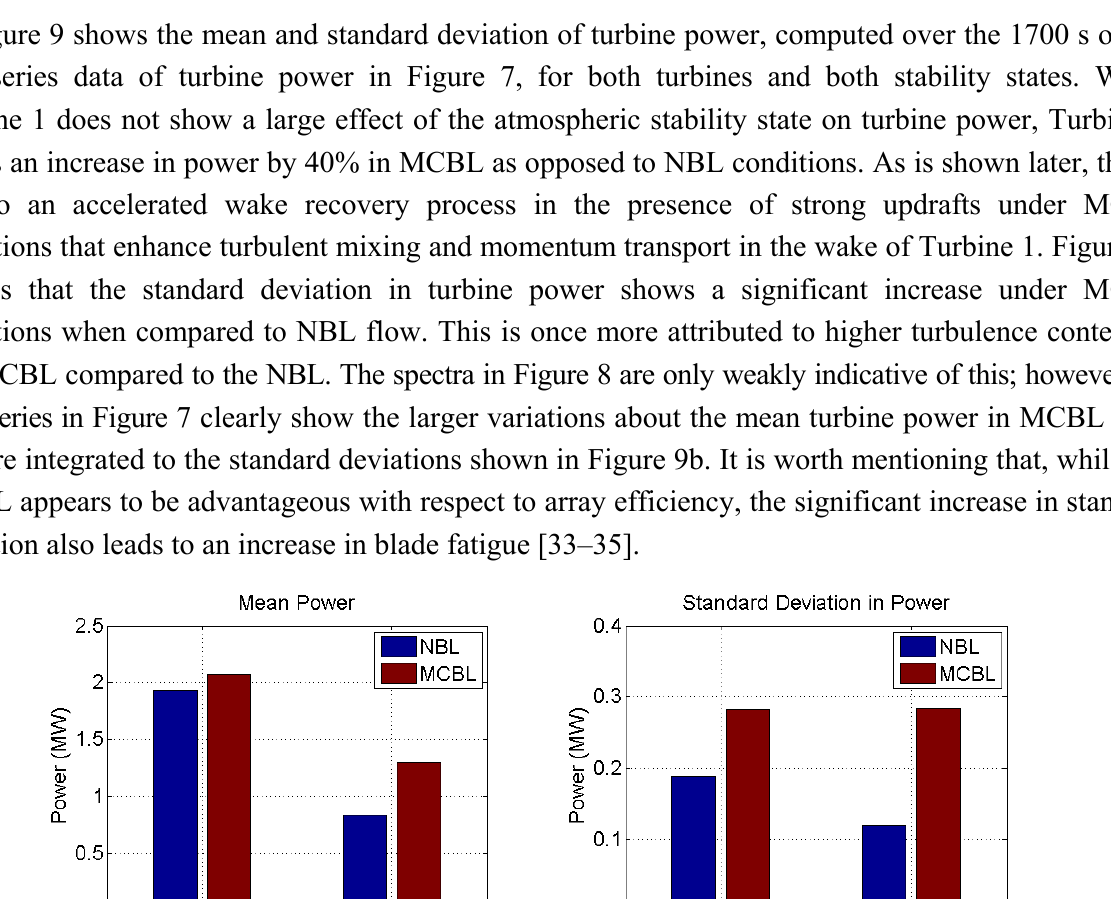
Figure 8. Power spectral density of power (Turbine-Turbine Interaction Problem, V Wind = 8 m/s). ( a ) Turbine 1; ( b ) Turbine 2.